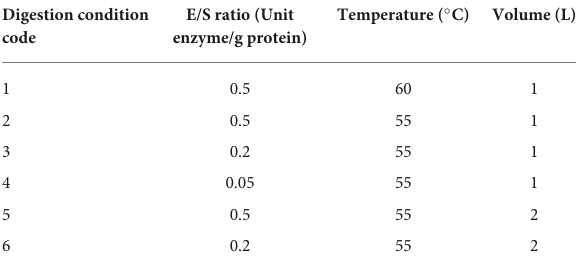
TABLE 1 Bioreactor processing conditions applied during enzymatic digestion up to 120 min of incubation with both Alcalase and